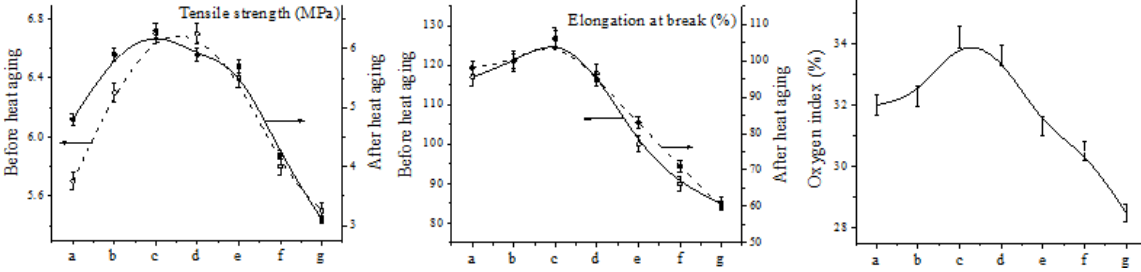
Figure 3: Mechanical properties and the oxygen index of DMC/SBR/MVQ composites.(a:50/0/100, b:50/20/80, c:50/25/75, d:50/30/70,